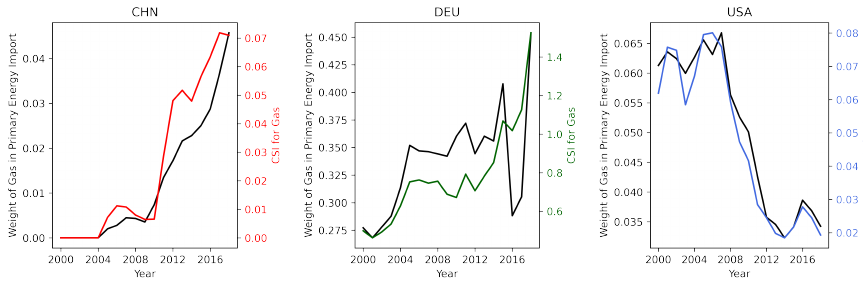
Figure 20. The evolution of CSI for natural gas importers.